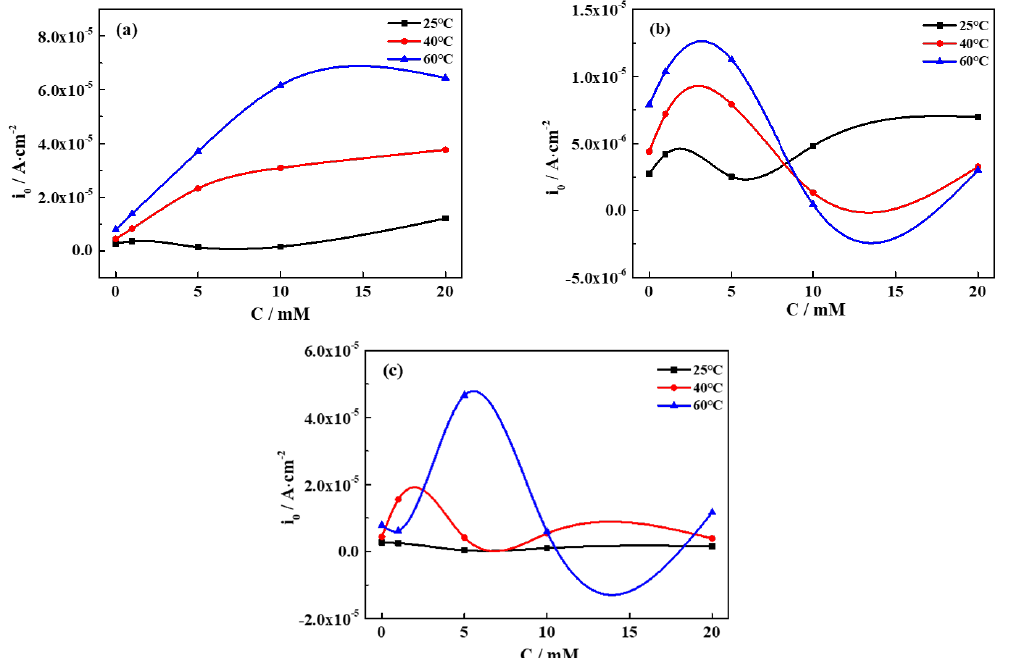
Figure 2. The variation in the corrosion current density with concentration/temperature in different simulated groundwaters. ( a ) SG + CaCl 2 ; ( b ) SG + Na 2 CO 3 ; ( c ) SG + Na 2 SiO 3 .